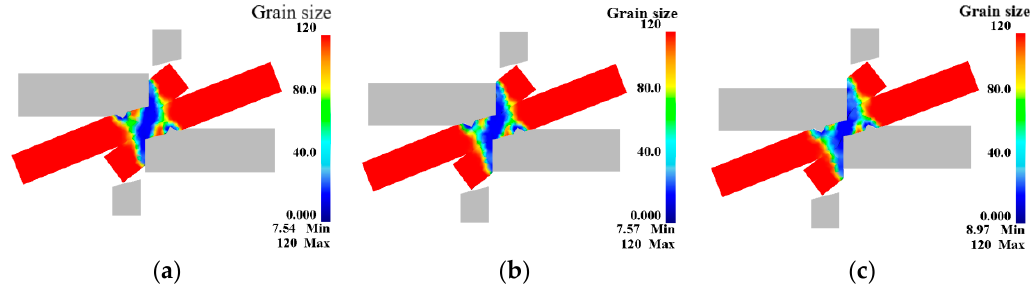
Figure 11. Dynamic recrystallized grain size: ( a ) L = 100%; ( b ) L = 125%; ( c ) L = 150%. Materials 2019 , 12 , x FOR PEER REVIEW